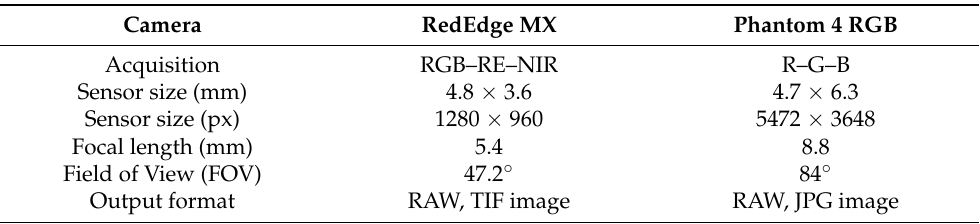
Table 1. Technical characteristics of the MicaSense RedEdge MX, and the Phantom 4 Pro Red, Green, Blue (RGB) camera.